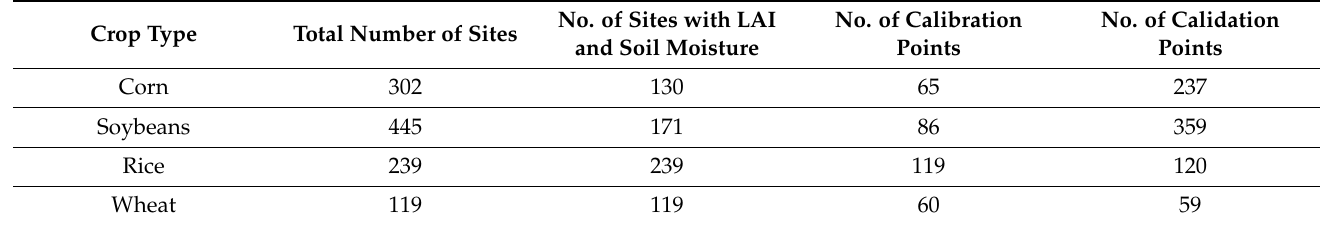
Table 4. Number of calibration and validation